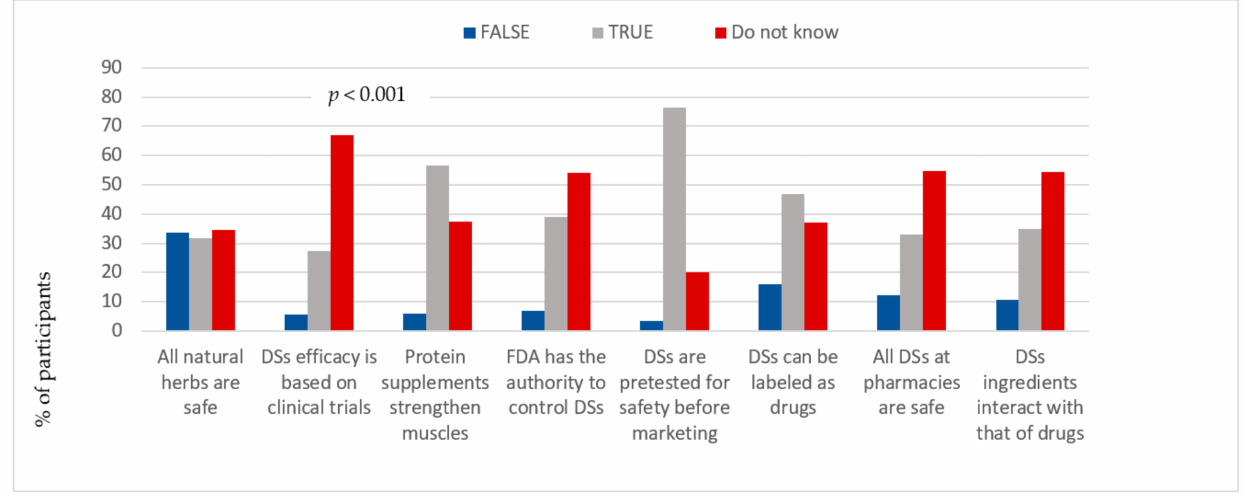
Figure 1. Responses of study participants to the DSs knowledge